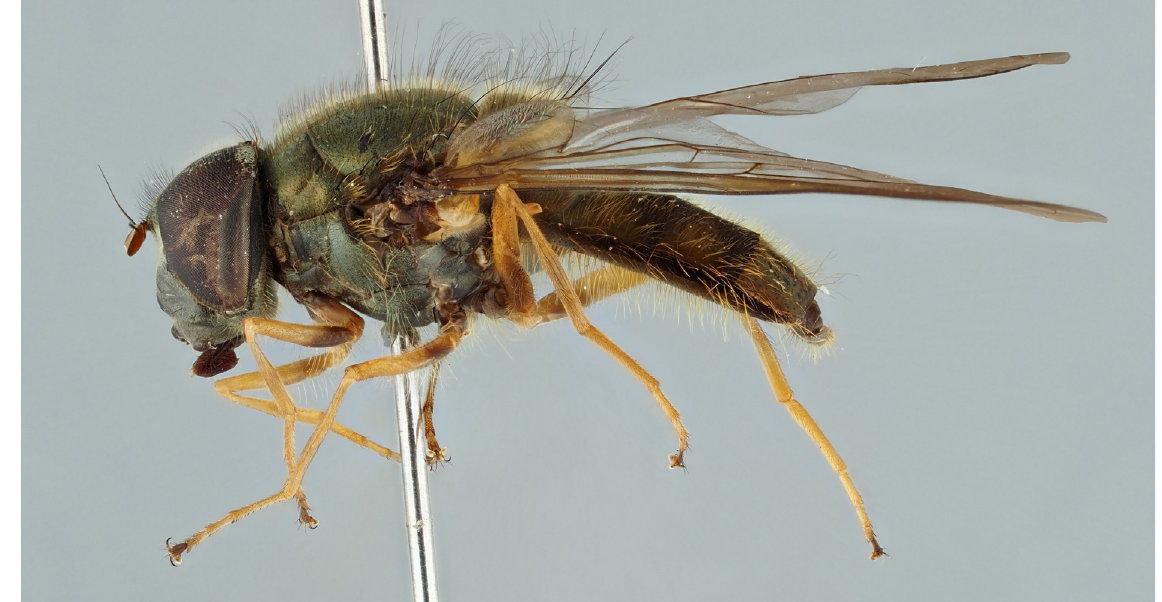
Fig. 38. Cheilosia lucida Barkalov & Cheng, 1998, ♂ (CSCA); lateral